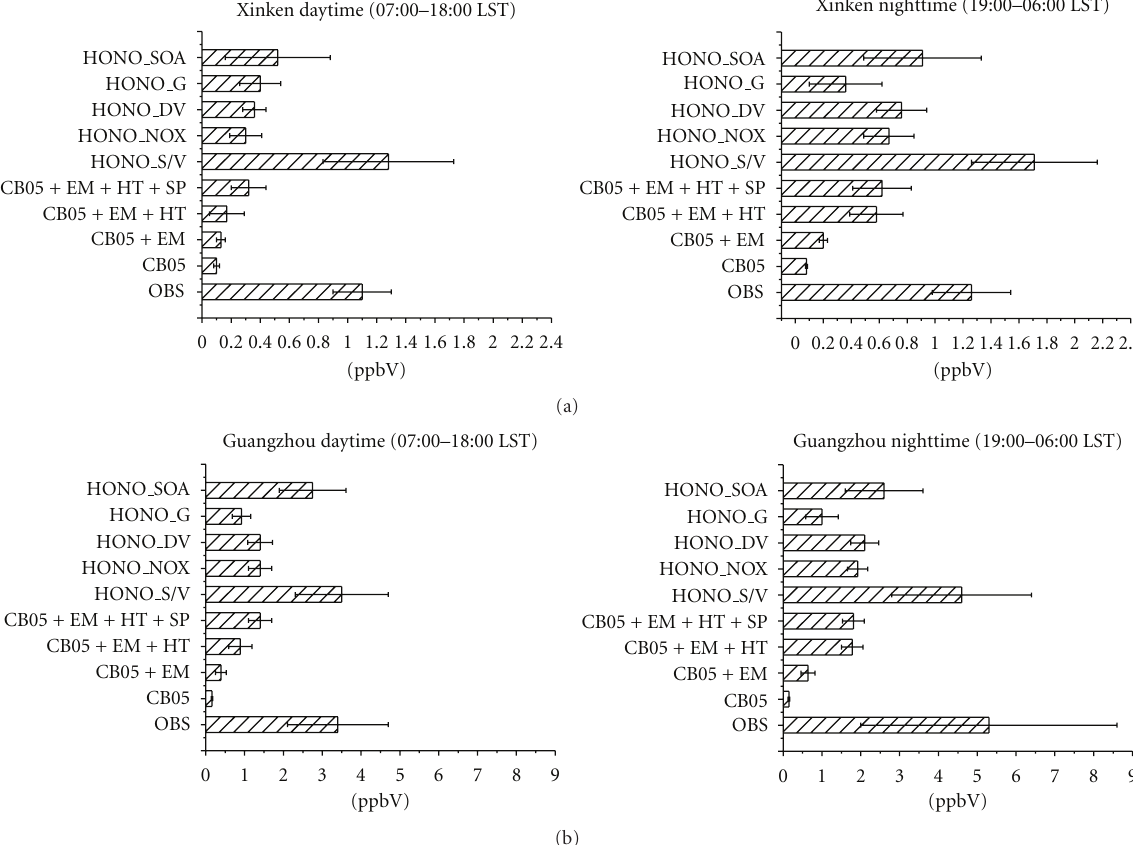
Figure 8: Simulated mean daytime and nighttime HONO concentration in (a) Xinken and (b) Guangzhou for di ff erent simulation case.